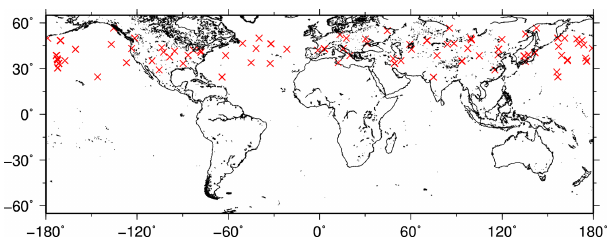
Figure 11. Geographical locations of coincident observations be- tween GOSAT and CALIPSO within 5km and 2min in 2010.